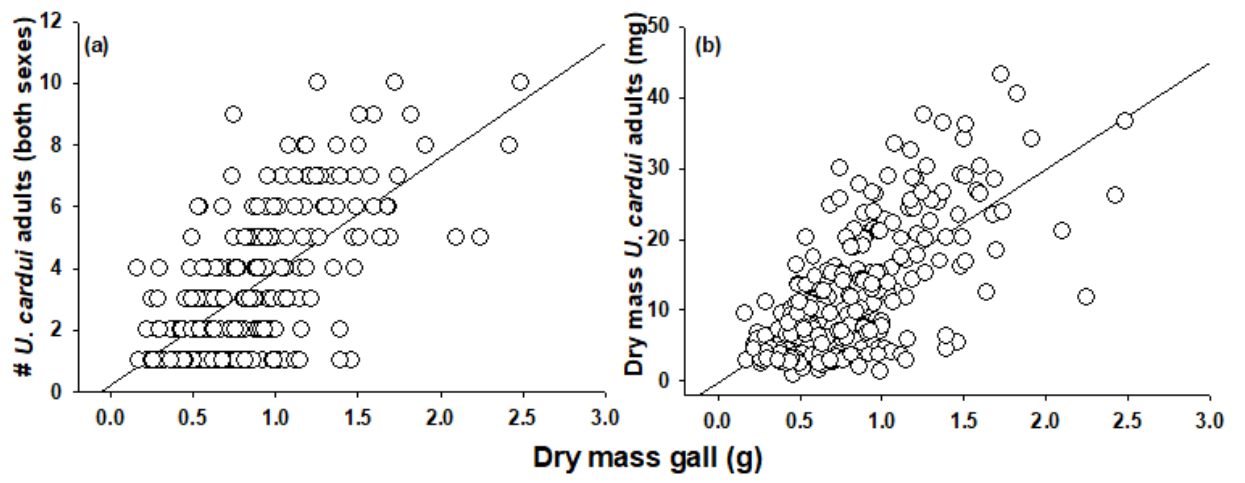
Figure 1. Correlations between ( a ) gall dry mass (g) and U. cardui density (male and female), R = 0.64, p < 0.0001 and ( b ) gall dry mass (g) and dry mass (mg) of all emerged adults, R = 0.63, p < 0.0001.